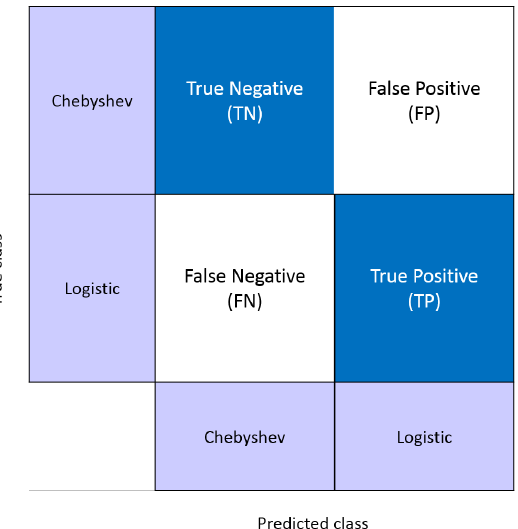
Figure 7. Calculation of sensitivity and specificity from the confusion